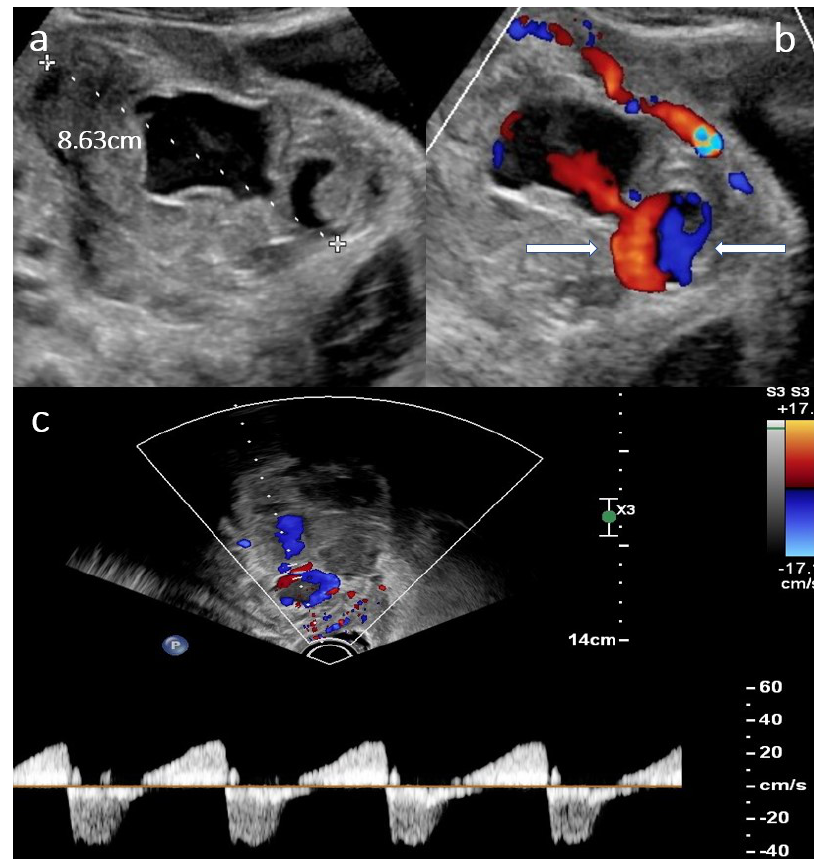
Figure 1. ( a ) Ultrasound findings in B-mode showing an anechoic lesion within an echogenic mass representing the UAP with surrounding hematoma. ( b ) Color Doppler showing Yin–Yang sign (between arrows). ( c ) Pulsed wave Doppler showing a to-and-fro pattern in the lower part of the image.